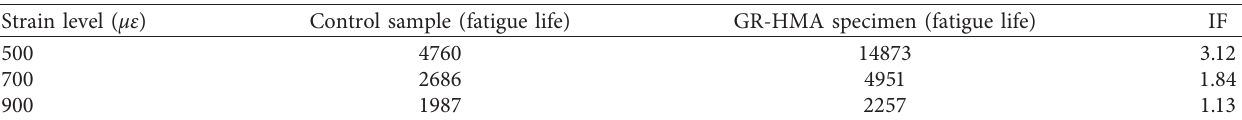
Table 6: Ratio of the number of load repetitions in the GR-HMA mixture specimens to the control specimen. Strain level ( με )